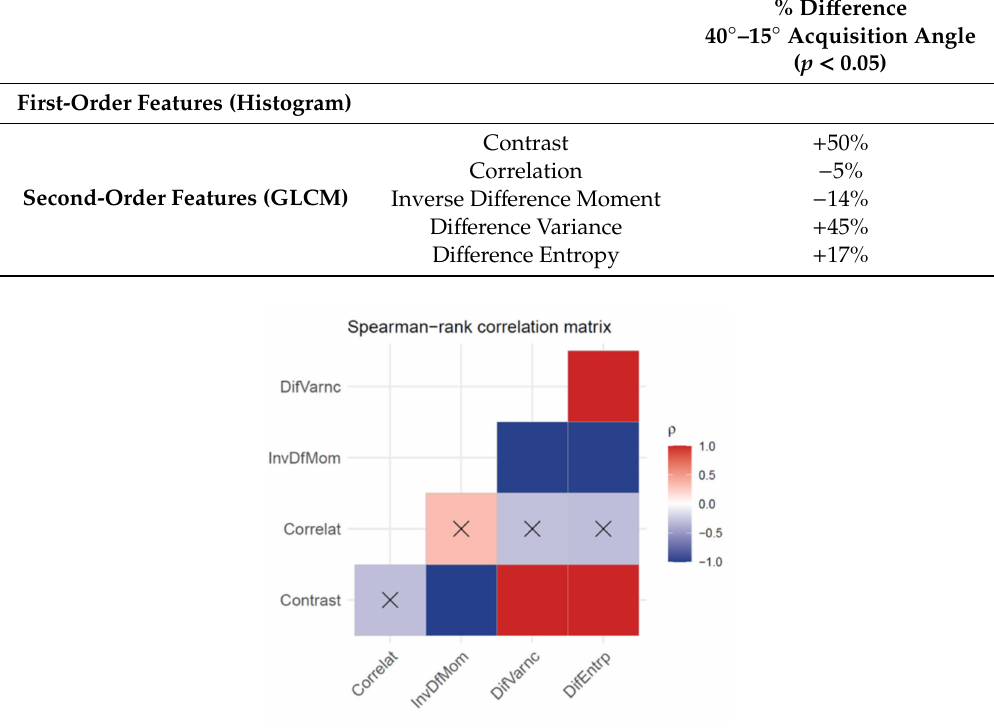
Figure 2. Spearman rank correlation matrix for features showing a significant di ff erence between 15 ◦ acquisition angle (standard mode) and 40 ◦ acquisition angle (high resolution mode) DBT images. Red and Blue elements indicate a positive and negative correlation, respectively, with a significance: p < 0.001. Crossed elements indicate that the correlation is not significant p > 0.05.